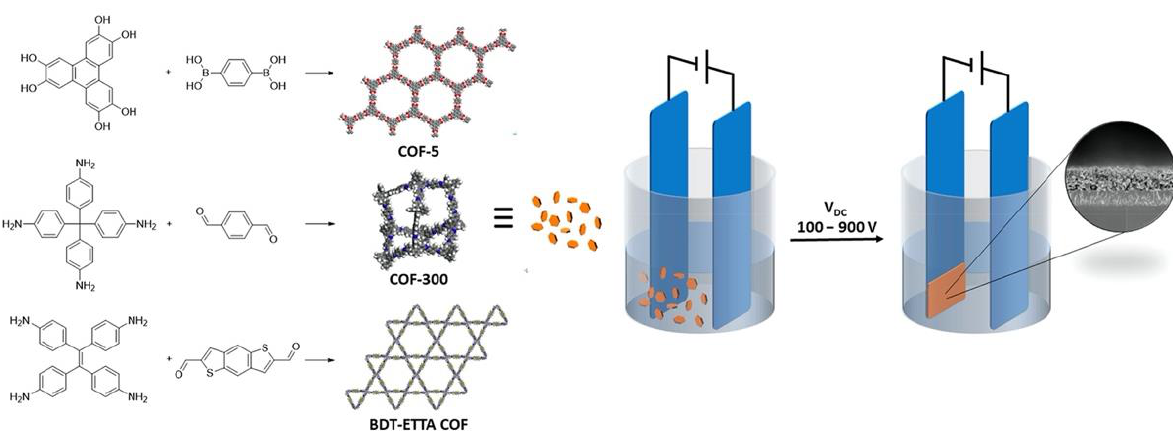
Figure 5. Electrophoretic deposition of COF particles on substrates (reproduced from Ref. [72] with permission from American Chemical Society).